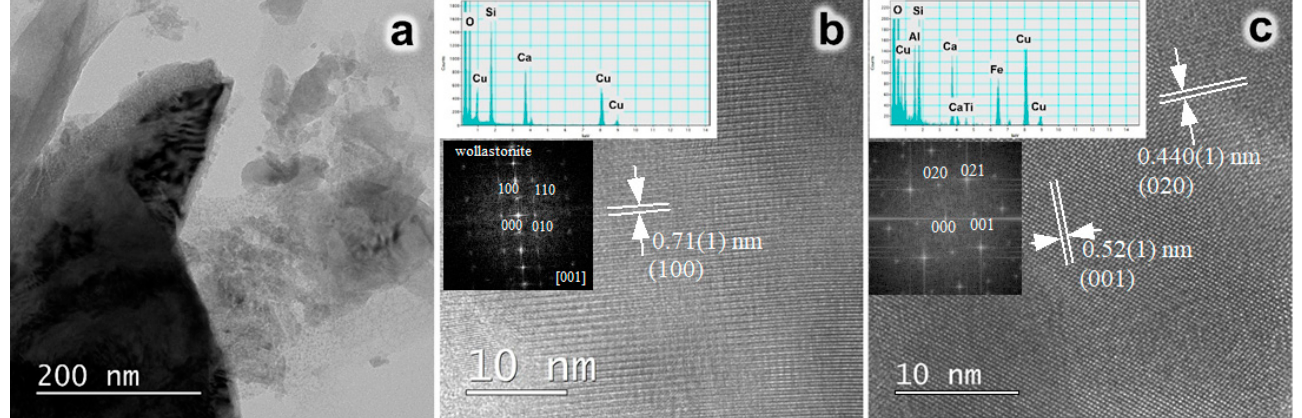
Figure 9. The HRTEM images of epidote breakdown products: ( a ) nanocrystals of breakdown products; ( b ) detailed view of wollastonite with its EDS spectrum; ( c ) detailed view of pyroxene with its EDS spectrum. Note that Cu in the EDS spectrum is from the Cu TEM grid.